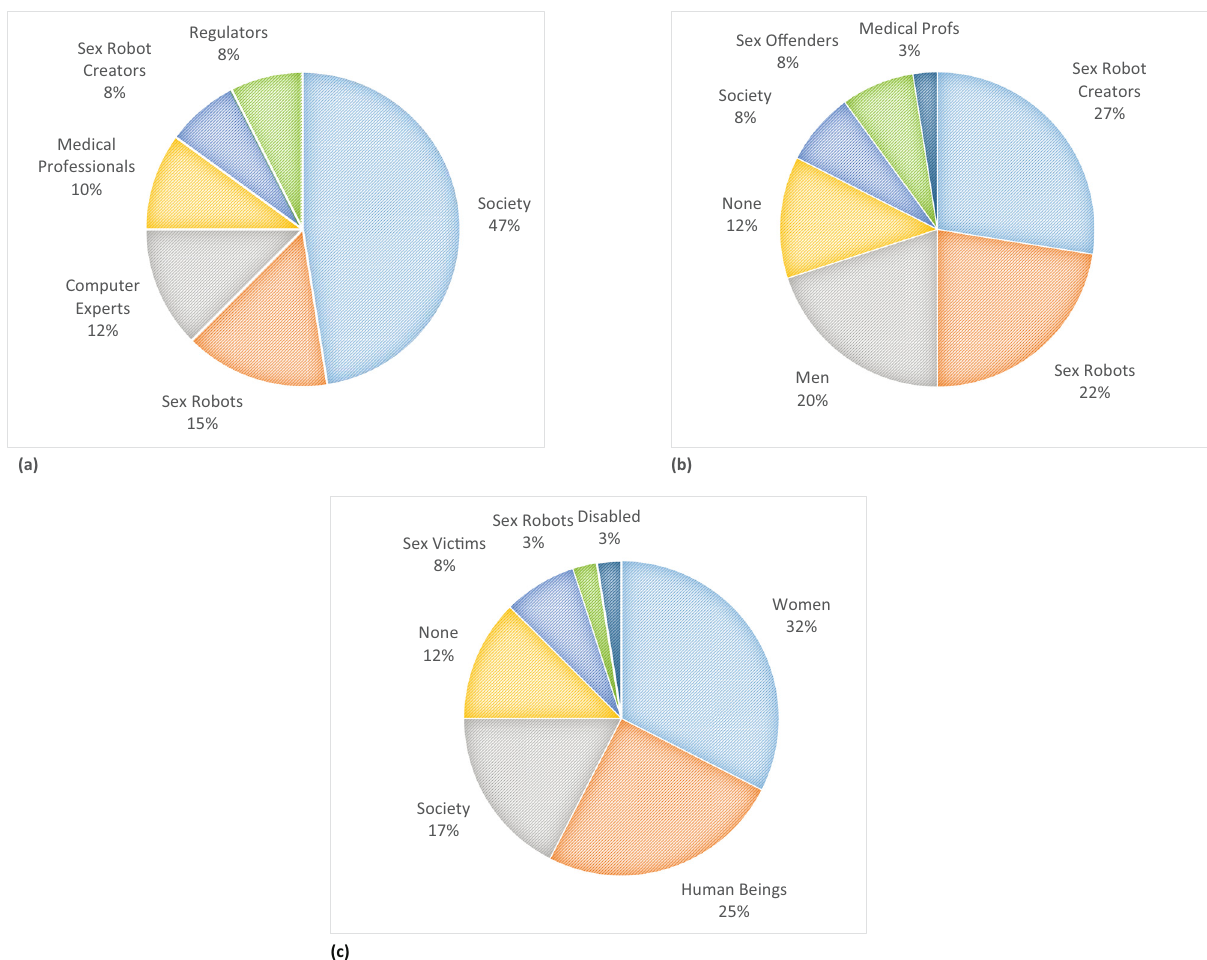
Figure 6: ( a ) Sex robot hero - coded character frequency ( Scopus ) . ( b ) Sex robot villain - coded character frequency ( Scopus ) . ( c ) Sex robot victim - coded character frequency ( Scopus )